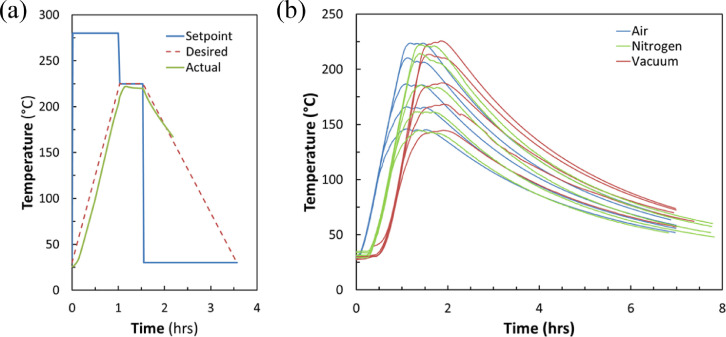
An example of a custom sintering program where a desired temperature of 225°C for 30 minutes was targeted is shown in (a). Actual sintering temperature profiles for all fifteen substrates are shown in (b). Here, the samples cool passively for approximately 5 hours before being removed from the oven.